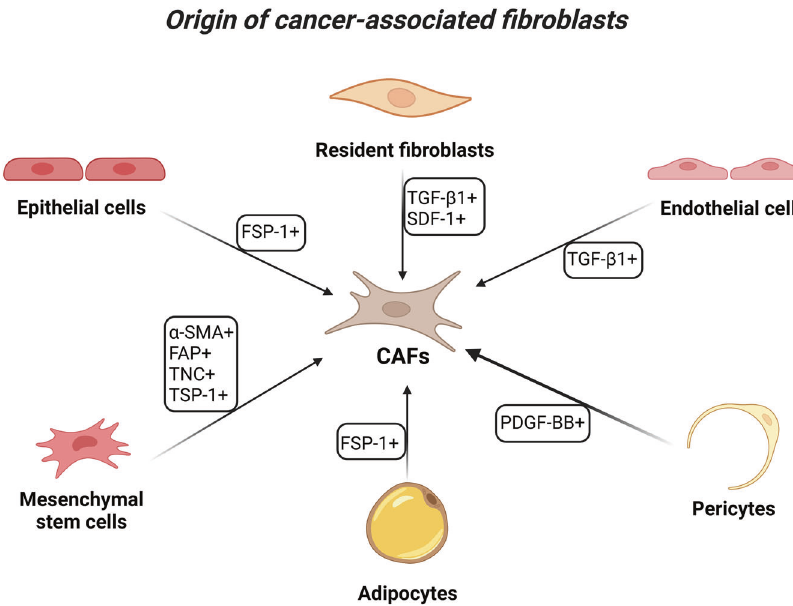
Fig. 1 Different origins of cancer-associated fi broblasts (CAFs) in cancer. The origin of CAFs can be quite heterogeneous, and the main sources of CAFs in TME are NFs. Growth factors like TGF-1 and stromal SDF-1 can be secreted by tumor cells to enable the conversion of NFs into CAFs, and CAFs in the tumor stroma do not undergo apoptosis. Other sources of CAFs include direct generation from MSCs, which can migrate to tumor sites in a way akin to fi broblast migration during wound healing. These migratory cells are drawn to cancer and differentiate into CAFs as a result of their attraction to the disease. In their cytoplasm, these CAFs exhibit particular markers such -SMA, FAP, TNC, and TSP-1. Moreover, epithelial cells can undergo EMT to develop into CAFs, and these CAFs maintain the genetic changes made to the parental genome. Due to the expression of mesenchymal lineage-committed marker genes, CAFs also originate from adipocytes. Endothelial and pericyte cells have the ability to transdifferentiate and add to the CAF population. Proliferating endothelial cells can undergo endothelial to mesenchymal conversions to develop CAFs under the effect of TGF-1 produced by cancer. By the in fl uence of PDGF-BB, pericytes are also a source of CAFs. (Created with